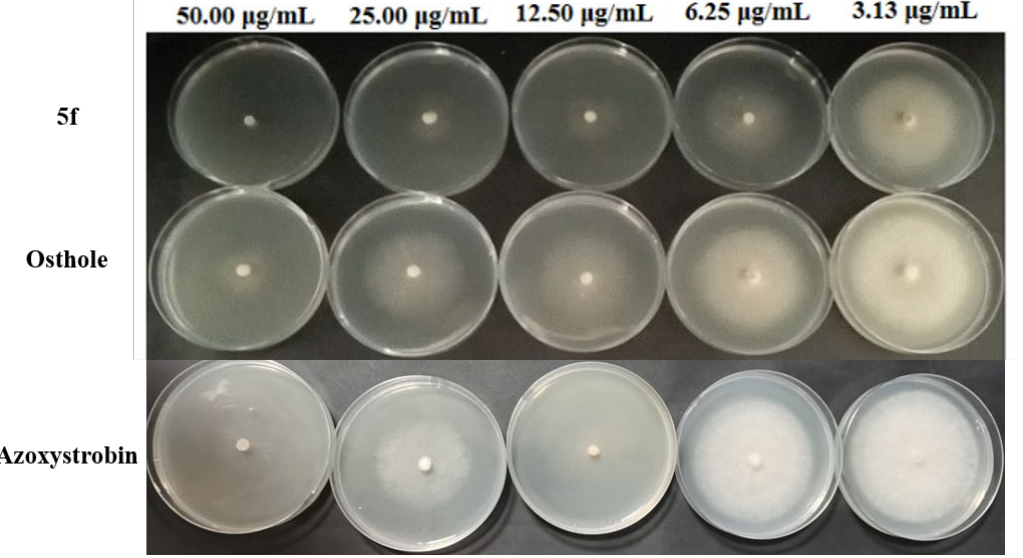
Figure 4. In vitro inhibition of mycelial growth of B. cinerea by compound 5f , Osthole and Azoxystrobin. Table 3. EC 50 values determination of some target compounds against B. cinerea .